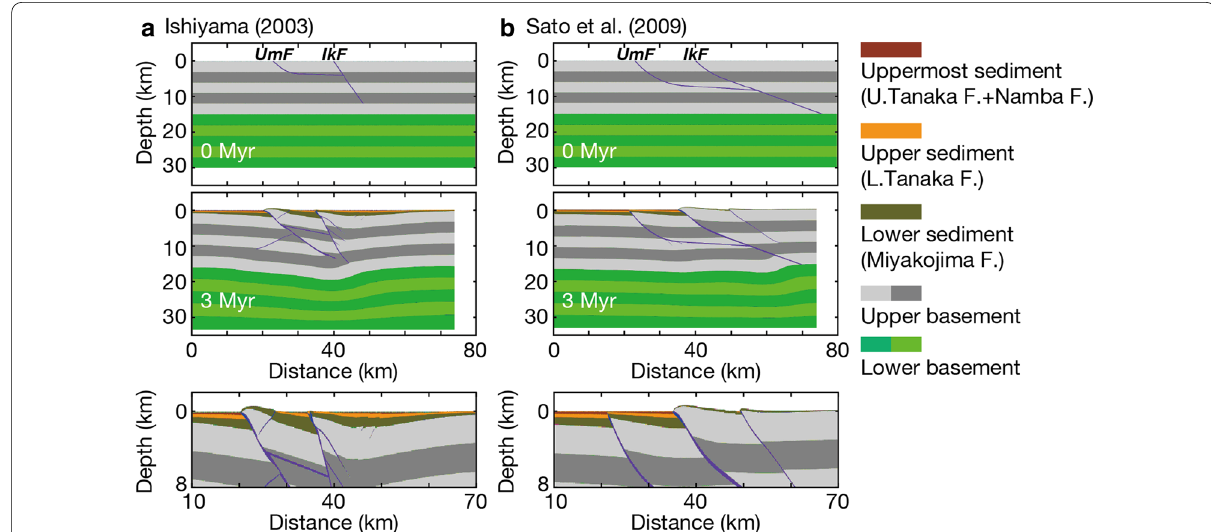
Fig. 12 Results of the numerical simulations for previously proposed fault geometries. a The initial geometry (upper), final geometry (middle), and close-up of the final geometry (lower) for the fault geometry of Ishiyama (2003) with a weakened friction coefficient μ w of ~ 0.3 (weakened friction angle φ w 17°). b The initial geometry (upper), final geometry (middle), and close-up of the final geometry (lower) for the fault geometry of Sato = et al. (2009) with μ w ~ 0.4 ( φ w 22°). The preexisting faults and newly formed faults (markers with a cumulative strain larger than 1) are illustrated = = in dark blue. UmF and IkF represent the surface positions of the Uemachi and Ikoma faults,